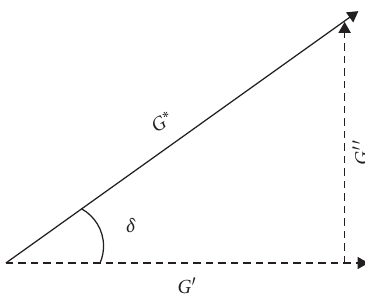
Figure 10: Modulus parameter